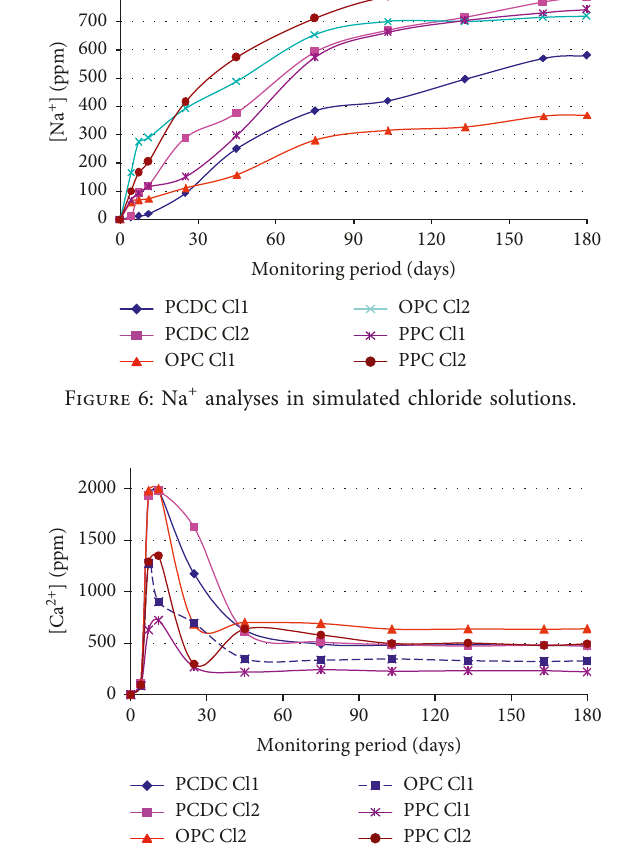
Figure 7: Ca 2+ analyses in simulated chloride solutions.